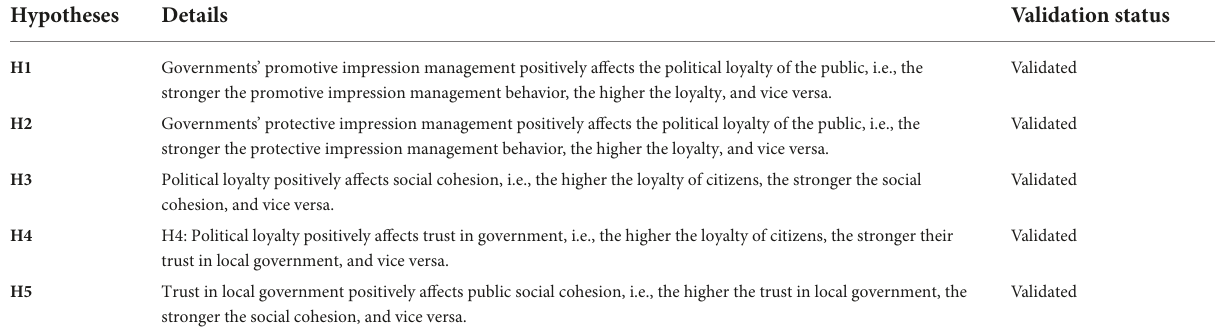
TABLE 8 Research hypotheses